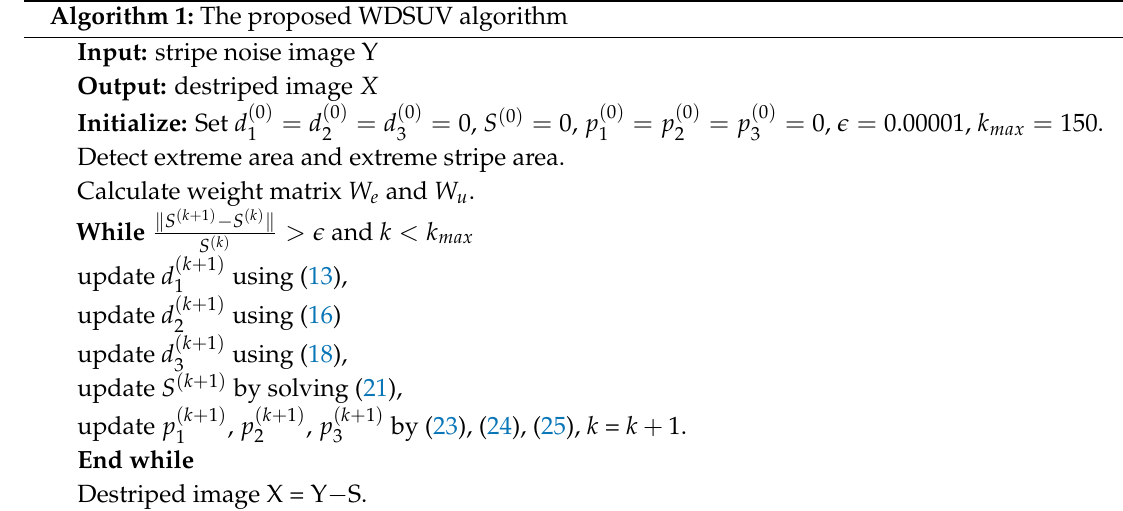
Algorithm 1: The proposed WDSUV